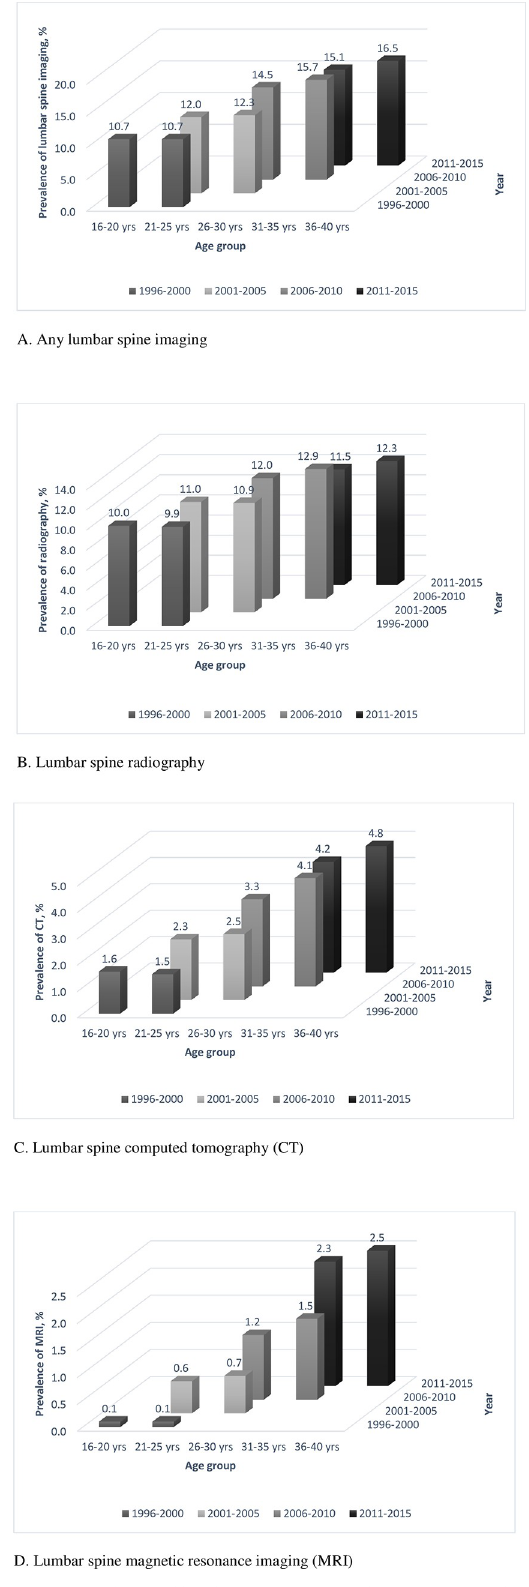
Fig 2. Prevalence of lumbar spine imaging by age group and time period. https://doi.org/10.1371/journal.pone.0243282.g002 PLOS ONE | https://doi.org/10.1371/journal.pone.0243282 December3,